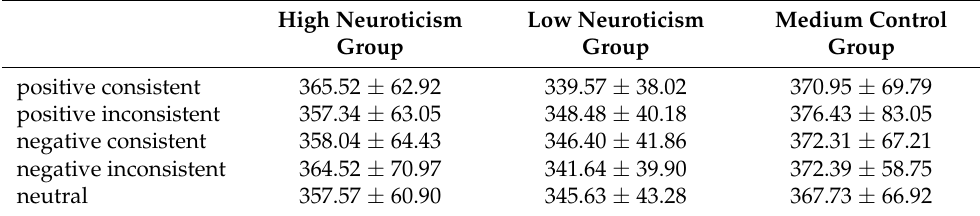
Table 4. Descriptive statistics of the five experimental conditions. ( M ± SD ; Unit: ms).